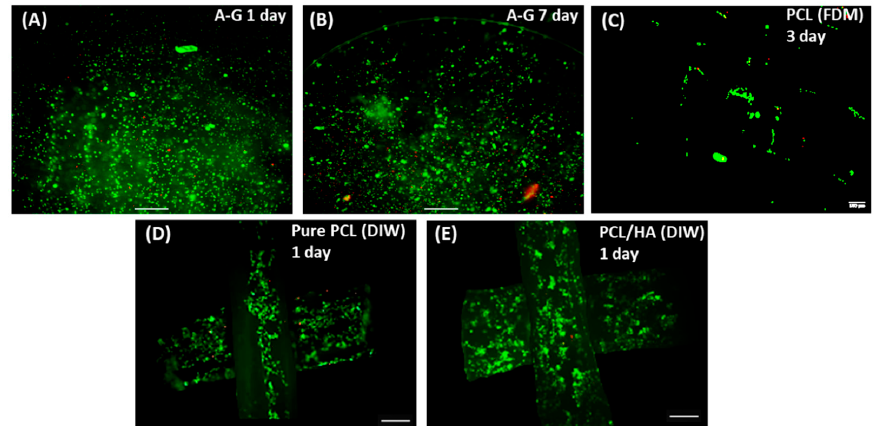
Figure 4. Confocal images showing viability live/dead assay for chondrocytes and HOB cells in